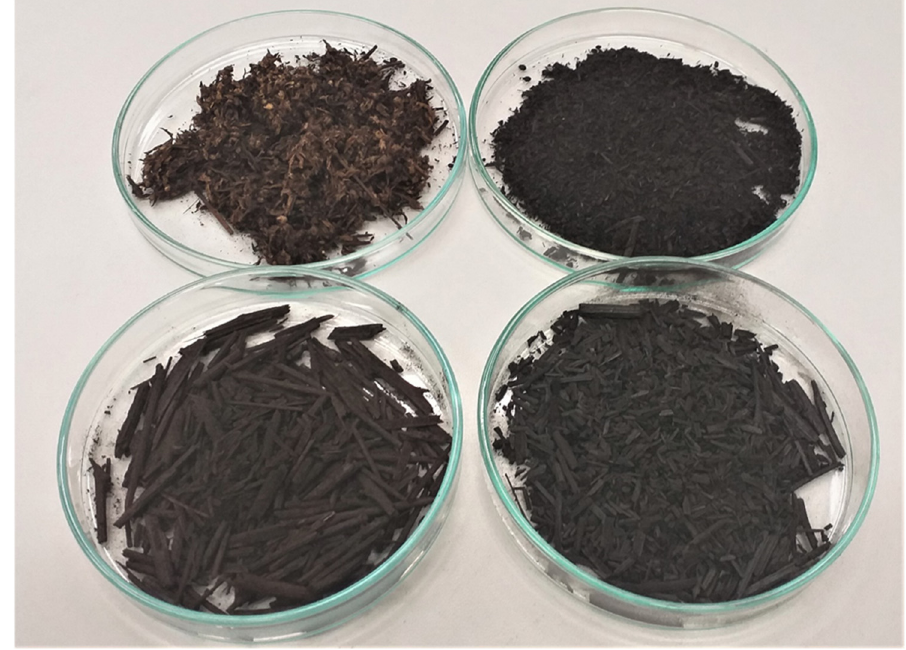
Figure 9. Pyrolysis products obtained at a temperature of 300 and 400